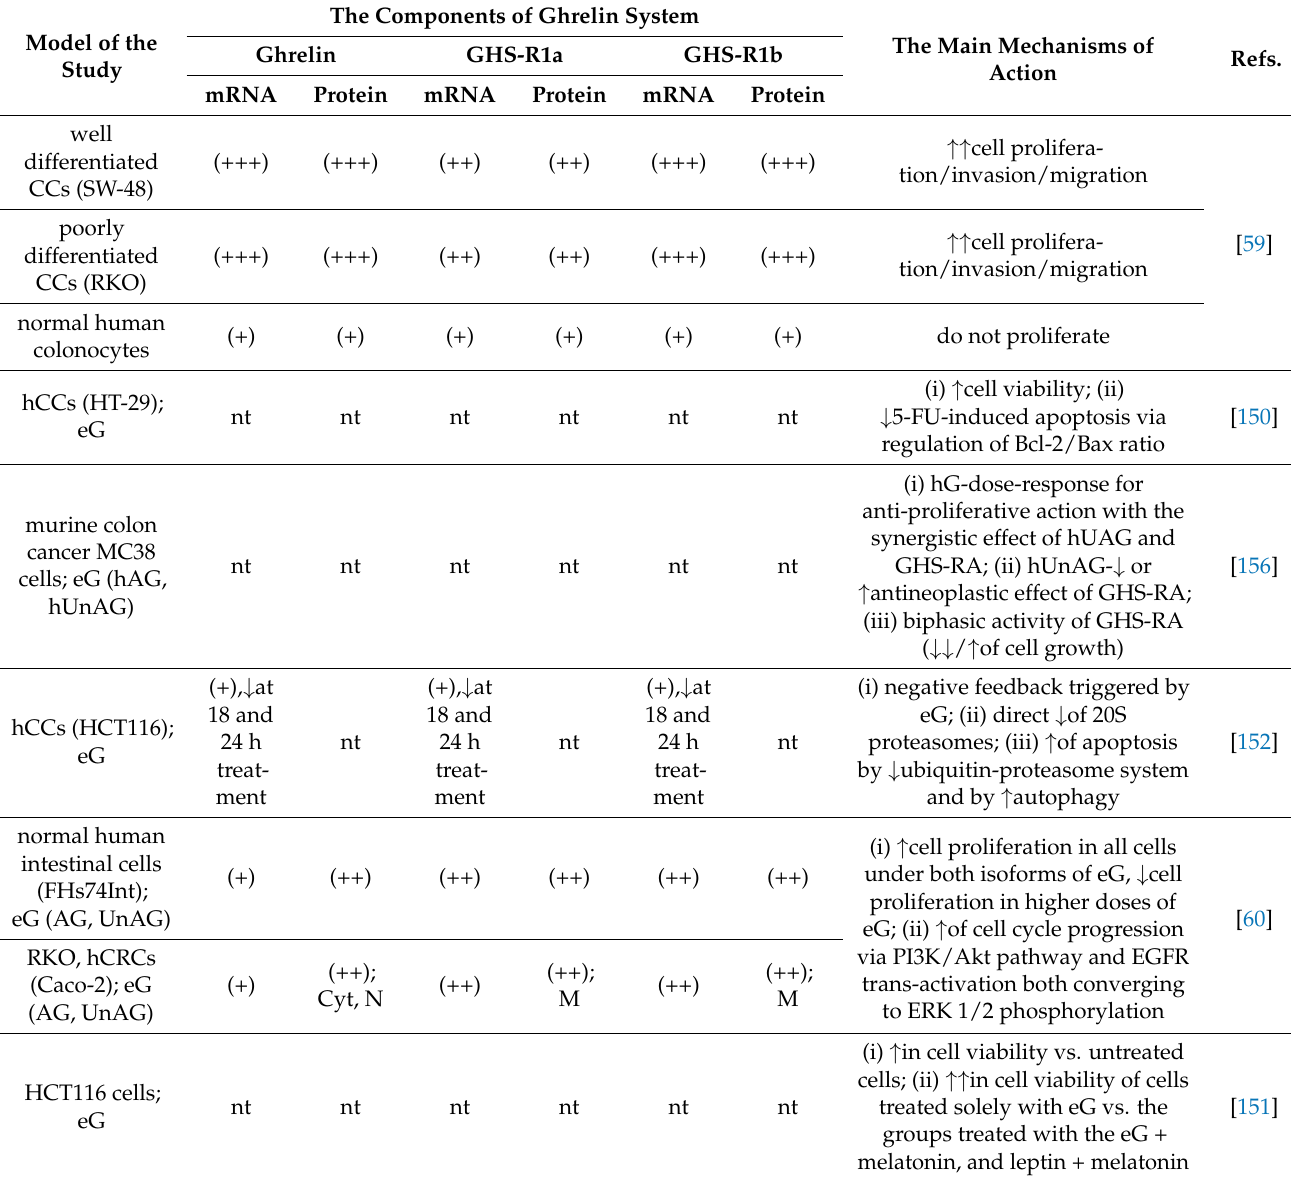
Table 3. The Potential Role of the Ghrelin System in Colorectal Carcinogenesis—in vitro and mouse model studies (*) on exogenous ghrelin in